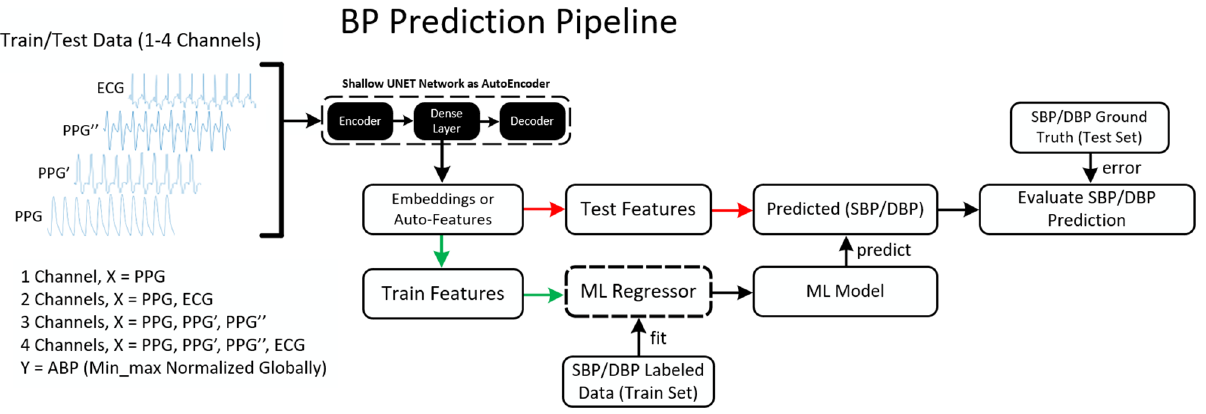
Figure 4. Complete pipeline for blood pressure (BP) prediction using a two-stage machine learning approach (dash means an iterative process).